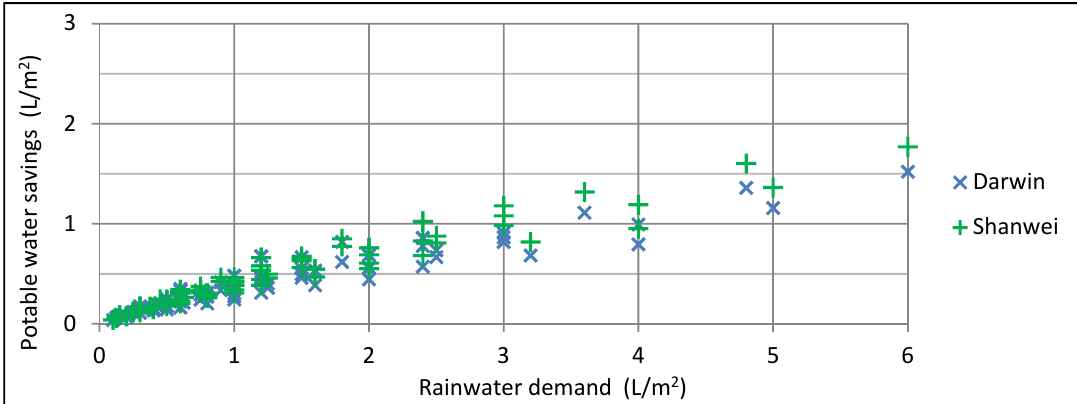
Figure 19. Correlation between potable water savings per catchment area and rainwater demand per catchment area for cities with annual rainfall greater than 1500 mm/year with periods of